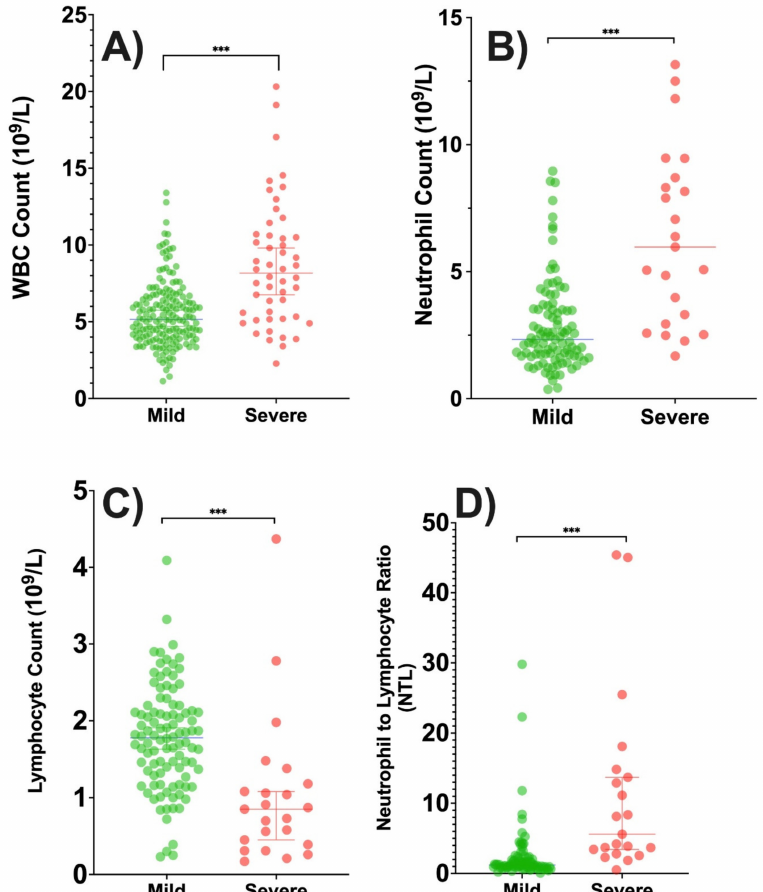
Figure 2. Box plots of patient blood test results after diagnosis by illness severity as assessed by the need for mechanical ventilation (MV). ( A ) White blood cell count by illness severity, with higher counts observed for more severe illness. ( B ) Neutrophil absolute count by illness severity, with higher counts observed for more severe illness. ( C ) Lymphocyte absolute count by illness severity, with higher counts observed for milder illness. ( D ) Neutrophil to lymphocyte (NTL) ratio by illness severity, with higher ratios observed for more severe illness. (***) Significant p -value less than